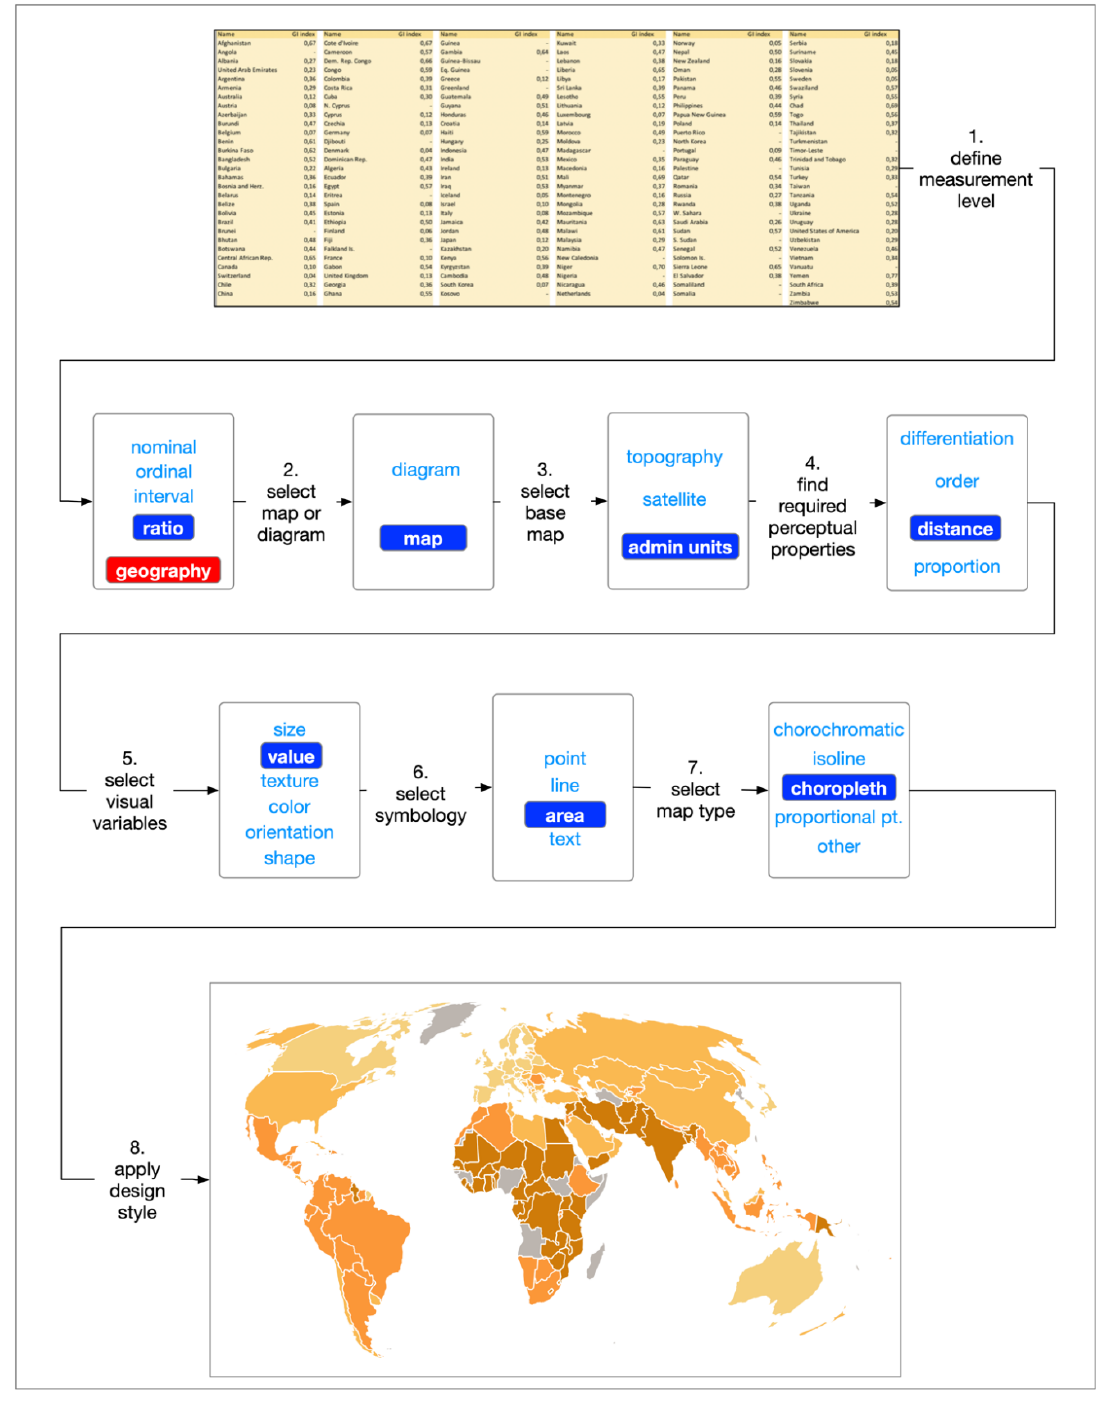
Figure 4. Major step in the cartographic workflow applied to visualizing the Gender inequality Index which is made up of multiple variables, many of them SDG indicators.